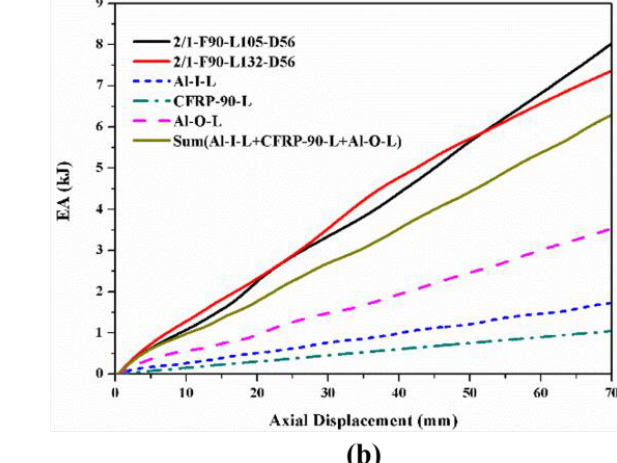
Figure 19. Hybrid effect of 2/1 hybrid tube with nominal outer diameter of 56 mm: ( a ) axial load – displacement curves; ( b ) EA – displacement curves.